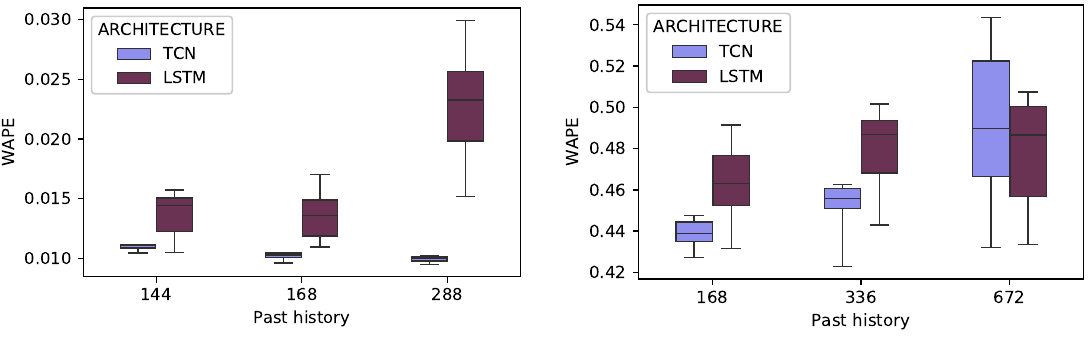
( b ) Results for the EV power consumption data. Figure 6. Distribution of weighted absolute percentage error (WAPE) results for all architectures depending on the past history window. Table 3. WAPE results of the best TCN and Long Short-Term Memory (LSTM) models for each possible value of input